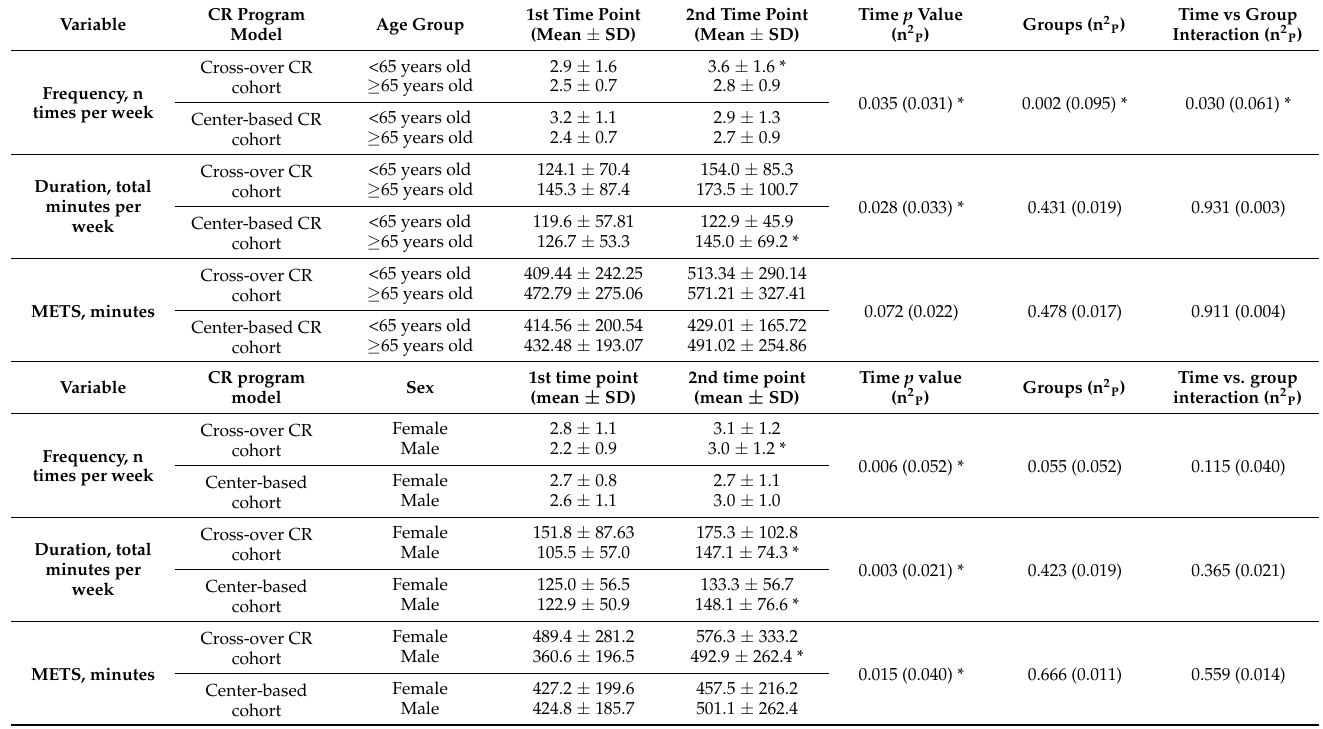
* Differences comparing to baseline. Moments represent the comparison between 1st and 2nd time point. Groups represent pandemic vs. center-based cohort. Abbreviations: CR = Cardiac Rehabilitation; METS = metabolic equivalent; SD = standard deviation; n 2 P= Partial Eta